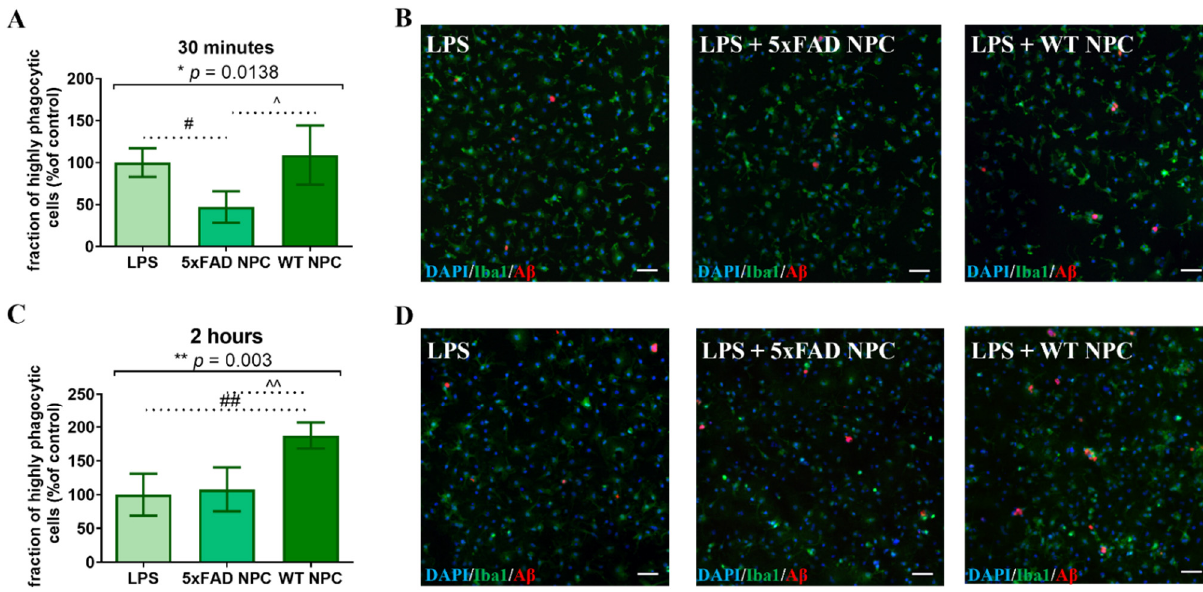
Figure 5. Dissociated SVZ explants (SVZ-NPC) from WT, but not 5xFAD mice, increase the fraction of microglia with high A β phagocytic activity. ( A ) Co-culturing of 5xFAD microglia with SVZ-NPC extracted from 5xFAD mice reduced the fraction of microglia with high A β phagocytic activity after 30 min. One-way ANOVA * p = 0.0138, post hoc analysis: 5xFAD SVZ-NPC vs. LPS # p = 0.0363, 5xFAD SVZ-NPC vs. WT SVZ-NPC ˆ p = 0.0168. The fraction of microglia with high A β phagocytic activity in LPS (control condition) served as 100%. ( B ) Representative images of microglia with high A β phagocytic activity after 30 min ( C ) Co-culturing of 5xFAD microglia with SVZ-NPC from WT mice increased the fraction of microglia with high A β phagocytic activity after 2 h. One-way ANOVA: ** p = 0.003, post hoc analysis: WT NPCs vs. 5xFAD NPC ˆˆ p = 0.0078, WT NPCs vs. LPS ## p = 0.0044. The fraction of microglia with high A β phagocytic activity in LPS (control condition) served as 100%. ( D ) Representative images of microglia with high A β -phagocytic activity after 2 h. Blue = DAPI, green = Iba1, red = A β , scale = 50 µ